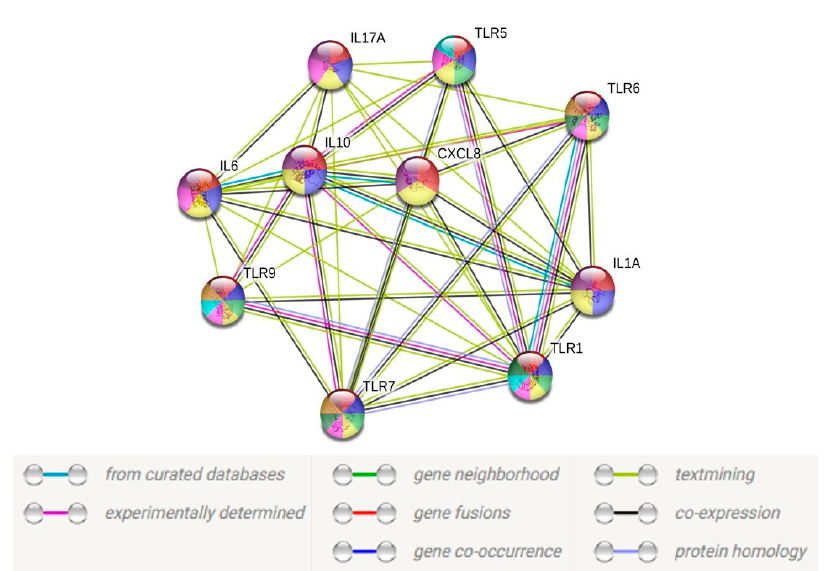
Figure 7. Protein–protein interaction network for 10 target genes with a medium confidence level 0.40. Connecting line color indicates the type of information used to infer the interaction. Purple line indicates experimental evidence; blue line indicates database evidence; green line indicates gene neighborhood; red line indicates gene fusion; dark blue indicates gene co-occurrence; yellow line indicates text mining; black line indicates coexpression of genes; light blue indicates protein